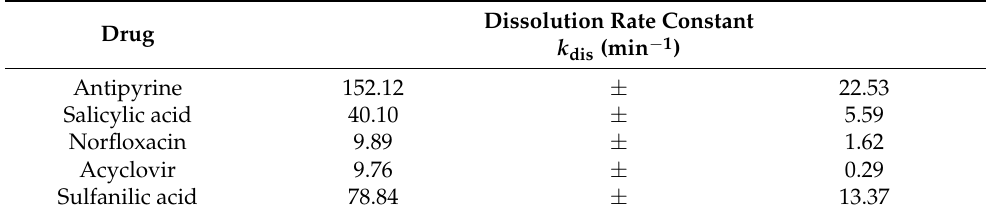
Table 4. Dissolution rate constant derived from the in vitro dissolution study using five model drugs. Drug